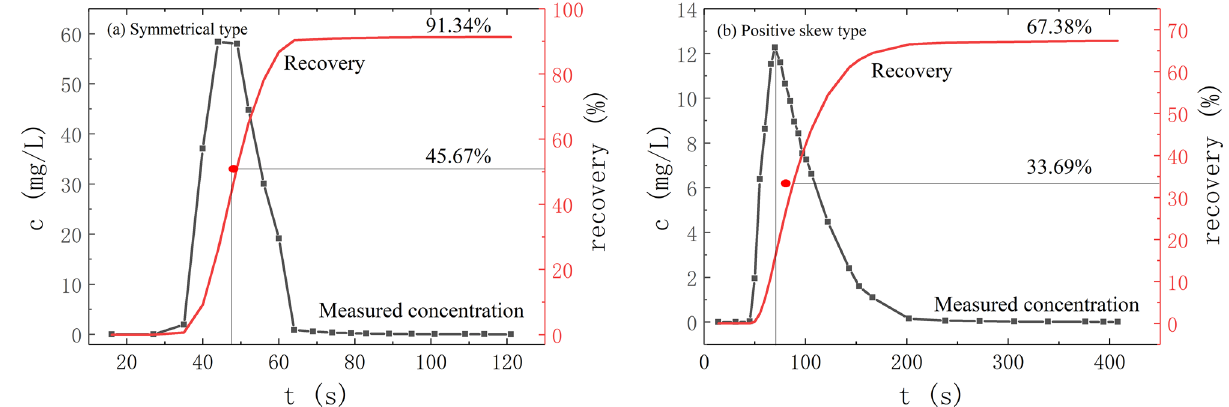
Figure 11. The method of BTC and cumulative recovery curve to determine concentration centroid.